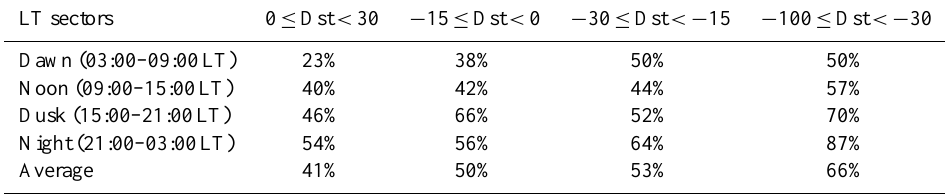
Table 4. The penetration ratio ρ of IBIPS inside geosynchronous orbit in four local time sectors for different Dst bins.